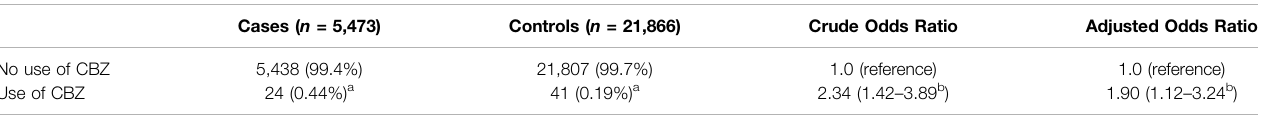
TABLE 3 | Carbamazepine (CBZ) and risk of out-of-hospital cardiac